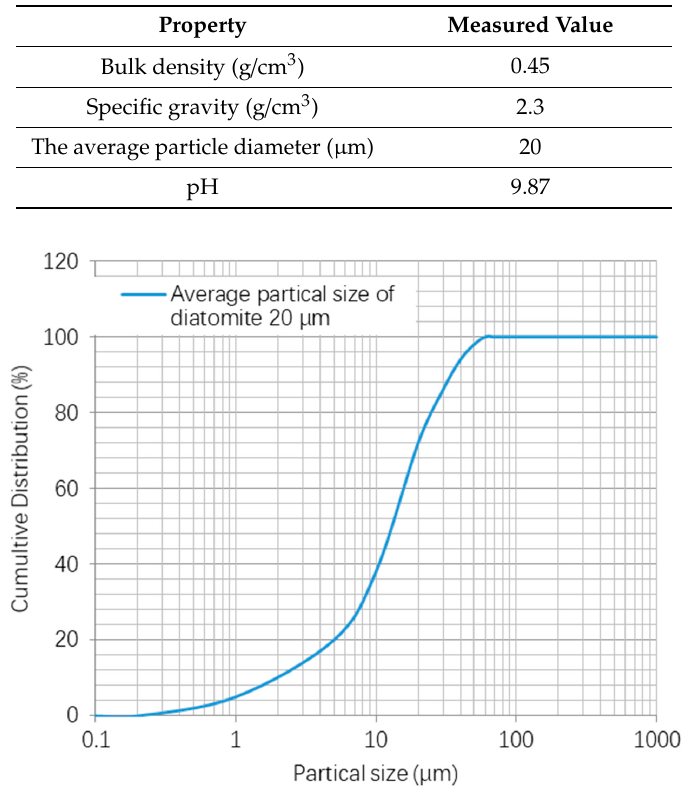
Figure 3. Particle size distribution of the diatomite.